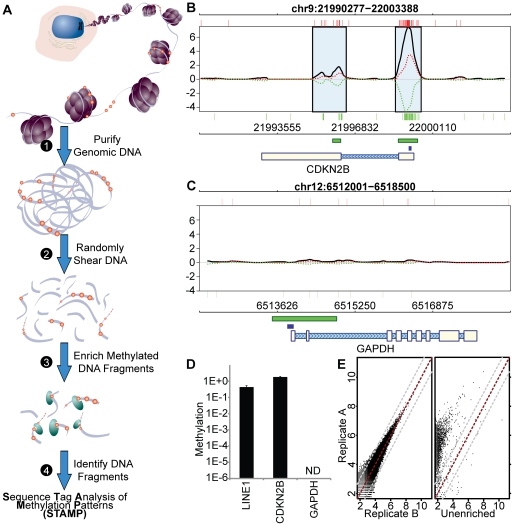
Overview of the STAMP assay and representative data.(A)The steps involved in the preparation of a methylated DNA library for massively parallel sequencing is illustrated schematically. 1) Genomic DNA is purified from cells. 2) The DNA is then randomly sheared by sonication. 3) Fragmented DNA containing methyl-CpGs, indicated as red spheres, is purified using His-MBD beads. 4) Bound DNA is purified and ligated to SOLiD sequencing adapters. The resulting DNA library is subsequently sequenced and mapped to the genome of interest. These sequence tags inform subsequent analysis of DNA methylation patterns. (B) Sequence tag maps and methylation profile is shown at the CDKN2B locus for the AML cell line M091. Upper, red vertical bars and lower, green vertical bars represent individual sequence tags mapping to the sense and antisense strands, respectively. The dashed red and green lines represent the methylation signal for the top strand and bottom strand, respectively. The black line represents the composite STAMP signal. A light blue box surrounds each densely methylated element (DME). CpG Islands are shown as green boxes below the plot and the gene body is indicated schematically. The location of the PCR amplicon used for bisulfite qPCR is indicated by a blue box. (C) STAMP analysis at the GAPDH locus, as described for panel (B), shows no methylation at this locus. STAMP analysis at the CDKN2B and GAPDH loci was confirmed by (D) Bisulfite qPCR (Methylight) (see Supporting Information S1, Table 1). In this panel, the fraction of total DNA present (assessed using methylation-insensitive primers) that is detected as methylated is shown. (E) STAMP analyses of biological replicate cultures of the AML cell line is shown in the left panel scattergram. A STAMP signal (log scale) for the replicates was calculated at 15,000 randomly selected loci. The red and grey dashed lines represent unchanged and two-fold changed signal The right panel compares one of the replicates to sequence tags obtained from unenriched DNA from the same cell line and demonstrates that the high replicate correlation depends upon His-MBD enrichment.